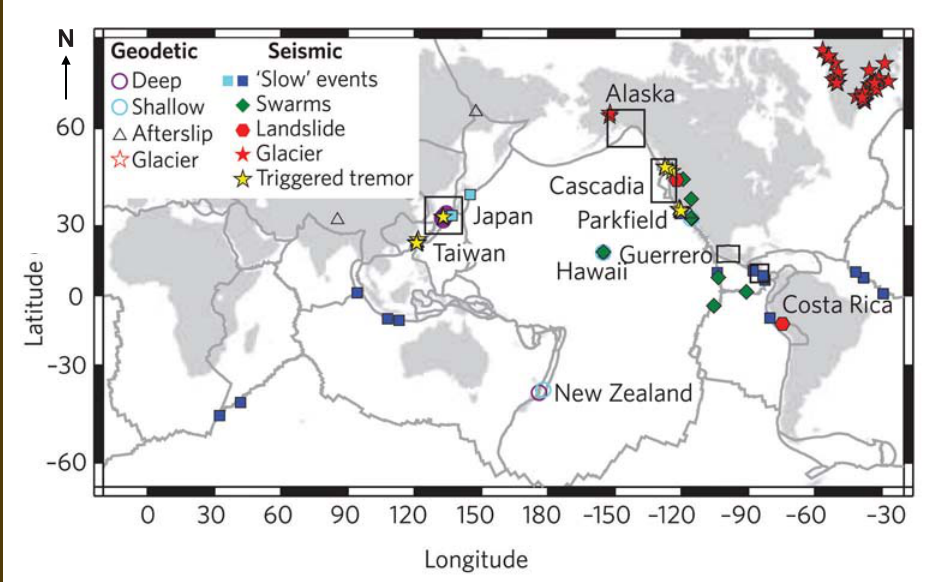
Figure 1. Map showing the global distribution of seismically and geodetically observed slow slip phenomena, from Peng and Gomberg (2010). Note that this map includes slow earthquakes and/or slow slip behavior from all fault types (not just restricted to subduction zones), and slow slip-type phenomena observed in landsliding and glacial settings.